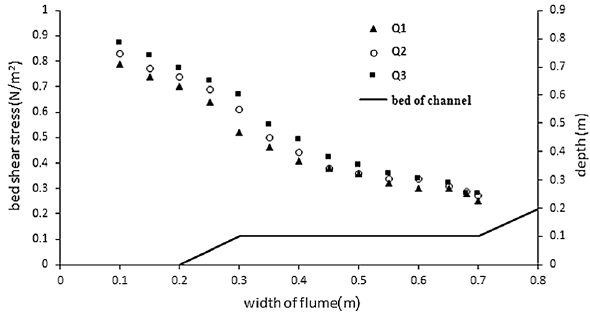
Fig. 3 Comparison between measured turbulent shear stress for dif- ferent flow rates with the smooth